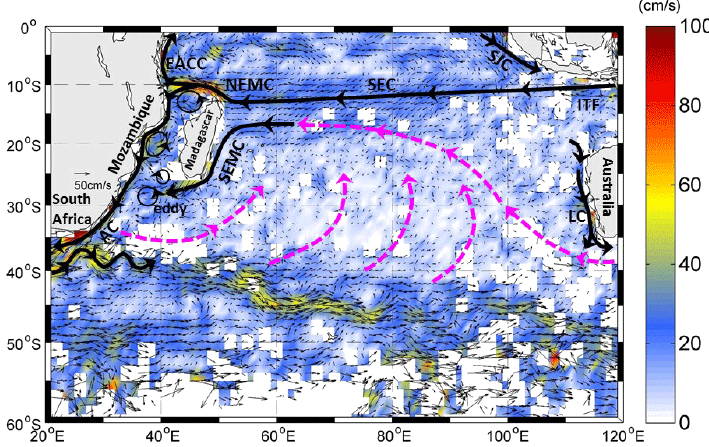
Figure 1. A schematic diagram of identified current branches in the South Indian Ocean, modified from Schott et al. (2009) and Beal et al. (2011). Mean flow in the SIO is from the average of drifter-detected velocity in bins with 1 ◦ × 1 ◦ resolution, and velocity less than 5cms − 1 is omitted (for data details refer to Lumpkin and Johnson, 2013). Schematic current branches are the South Java Current (SJC), Indonesian Throughflow (ITF), South Equatorial Current (SEC), Northeast and Southeast Madagascar Current (NEMC and SEMC), East African Coast Current (EACC), AC (Agulhas Current), and Leeuwin Current (LC). The subsurface return flow is shown in